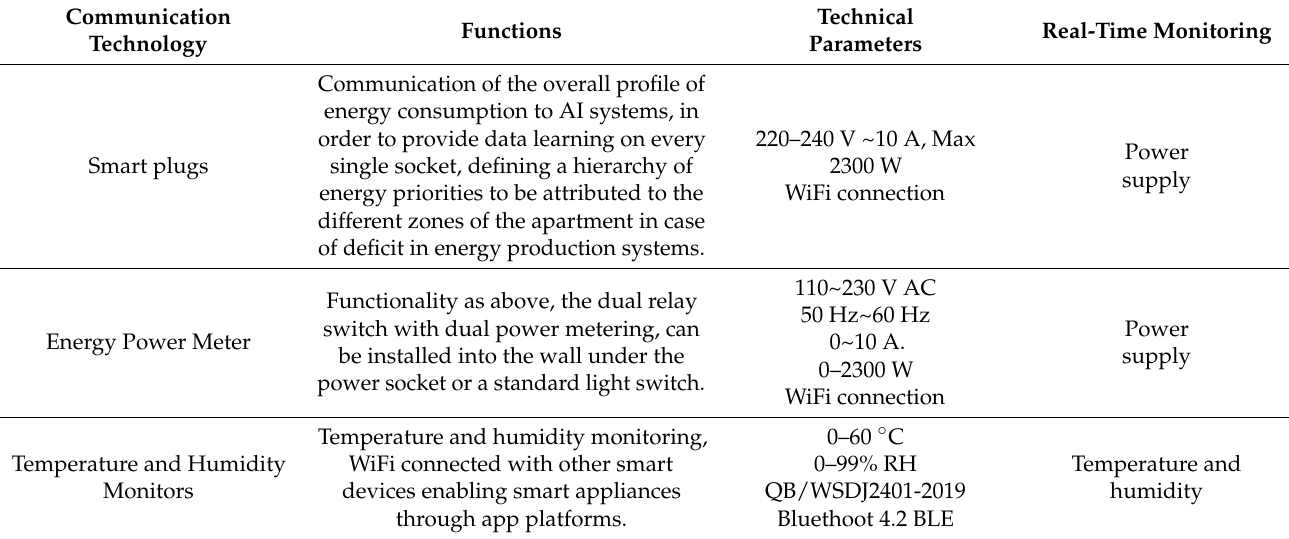
Table 1. Review of the implemented IoT devices.